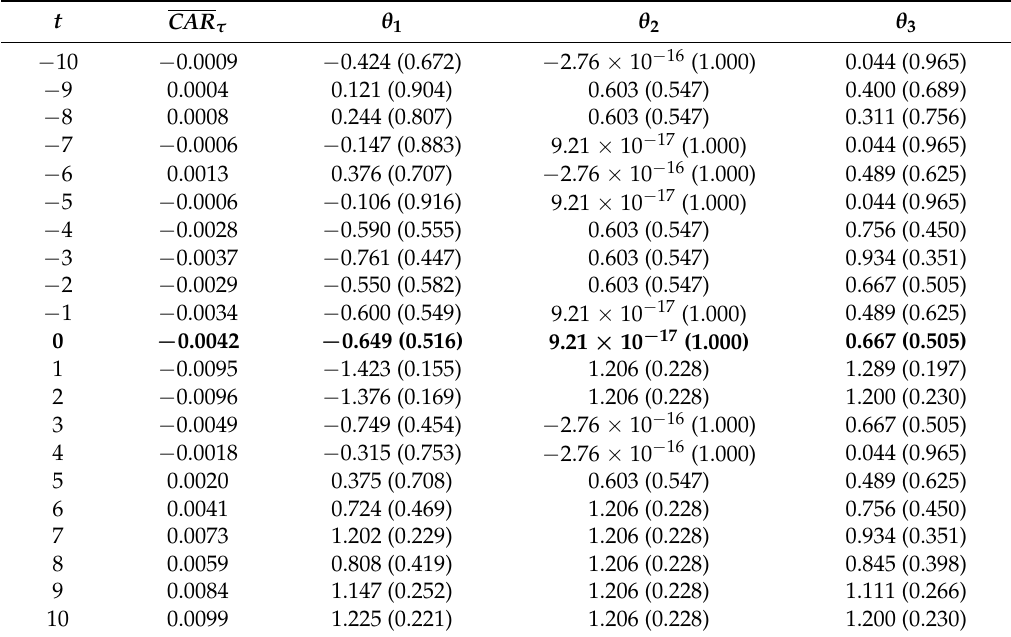
Table 1. Stock market reactions to Brexit, CEE regional